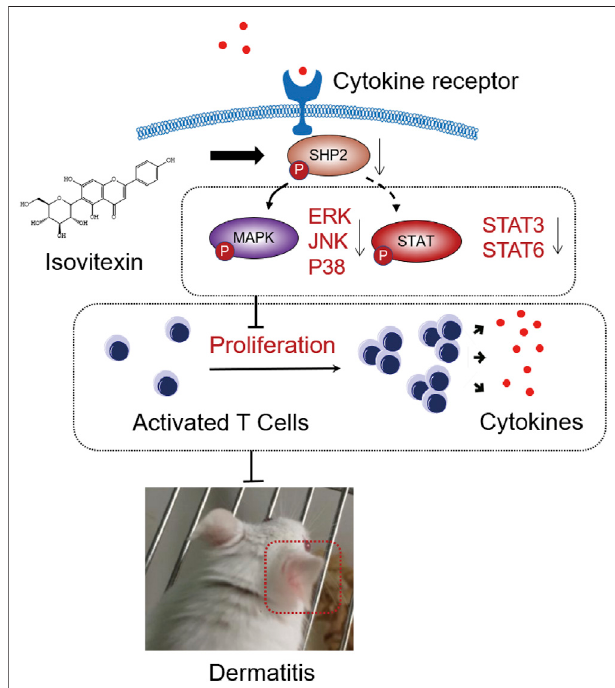
FIGURE 8 | Graphical abstract. When contact hypersensitivity occurs, Tcellsactivated produceproin fl ammation andchemokine.Tcellsproliferation anddifferentiationmediatedbyreceptortyrosinekinases(RTK)activation,and upregulated its downstream SHP2 protein, MAPK signaling, STAT signaling. On the other hand, isovitexin bind to SHP2 inhibits MAPK signaling, STAT signaling and its dependent deactivating programs in T cells, thus decreasing their production of in fl ammatory cytokines and reducing the severity of dermatitis.